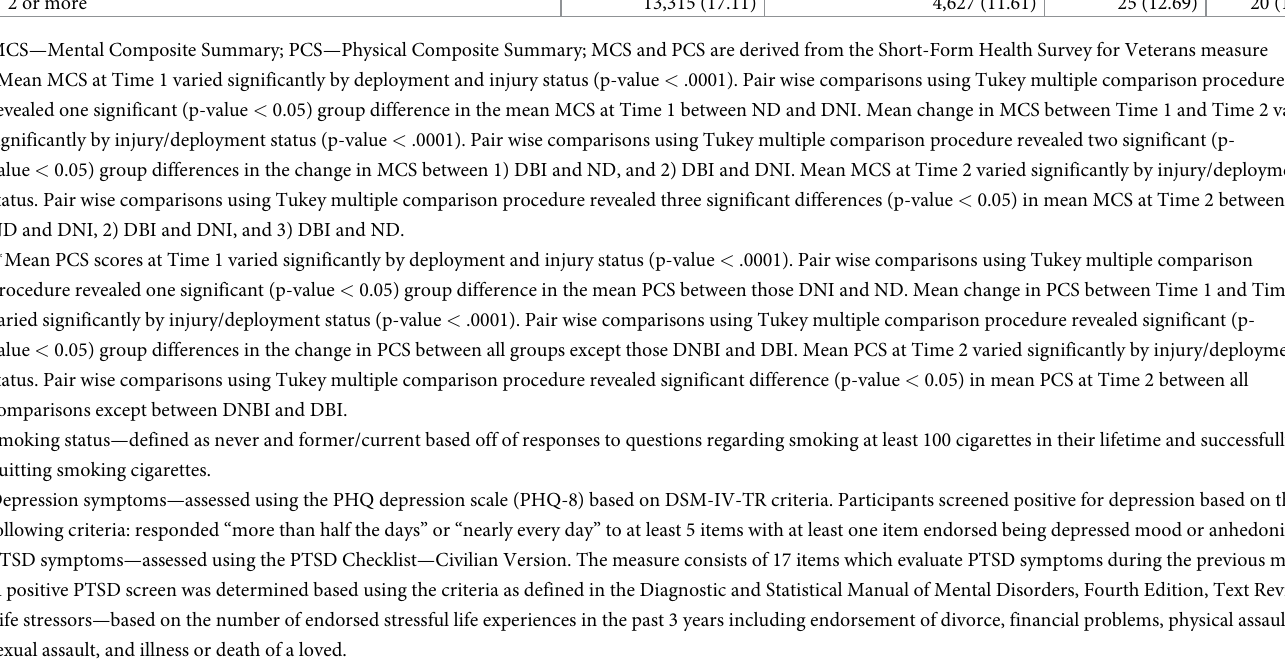
-1.2, DNI -2.0, DNBI -3.3, and DBI -3.8; p-value < .0001; Table 1 and Fig 3). Pairwise compar- isons revealed three significant (p-value < 0.05) group differences in the change in MCS between those ND and the three deployed groups. Finally, mean MCS at Time 2 varied signifi- cantly by deployment and injury status (Table 1 and Fig 3) and pairwise comparisons revealed three significant differences (p-value < 0.05) in mean MCS at Time 2 between 1) ND and DNI, 2) DNI and DBI, and 3) ND and DBI. Similar trends were observed for PCS with more pronounced differences observed by deployment and injury status. Mean PCS at Time 1 varied by deployment and injury status (mean of 53.0 for ND, 54.9 for DNI, 54.2 for DNBI, and 54.4 for DBI; p-value < .0001; Table 1 and Fig 4) and pairwise comparisons revealed a significant (p-value < 0.05) group difference between ND and DNI’s mean Time 1 PCS. Mean change in PCS between Time 1 and Time 2 varied significantly by deployment and injury status (mean change for ND -0.7, DNI -2.2, DNBI -8.8, and DBI -10.1; p-value < .0001; Table 1 and Fig 4) with significant